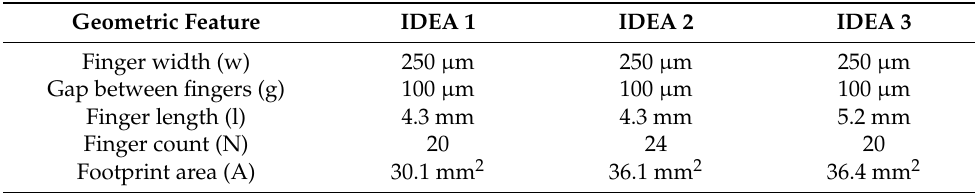
Table 1. Geometric features of the three fabricated IDEAs.